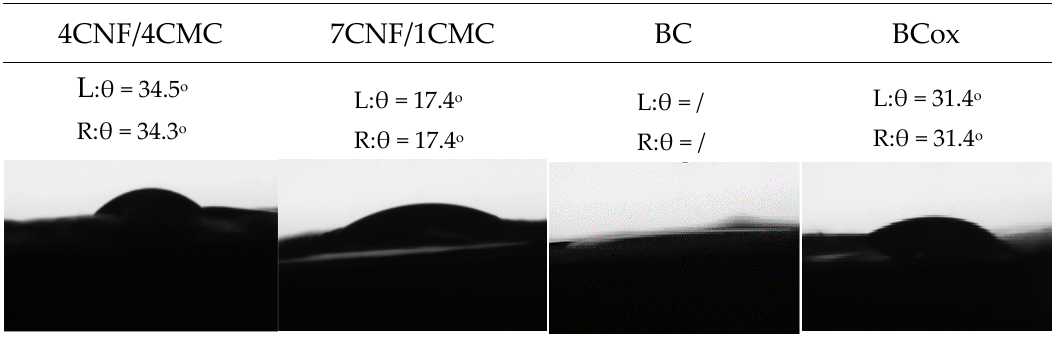
Figure 4. Contact angle ( θ ) and respective photographs of diverse membranes .